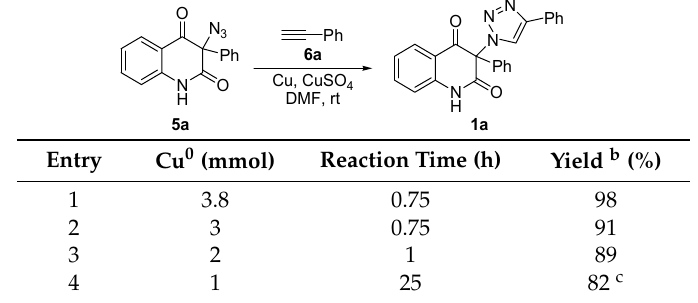
Table 1. The Effect of Granular Copper to the Conversion of 5a into 1a a .